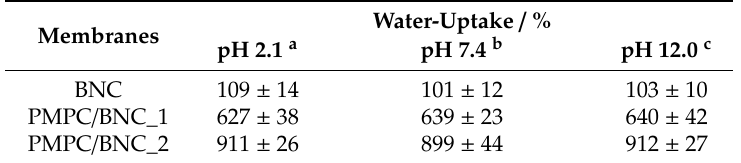
Table 2. Water-uptake (water-uptake) of neat BNC and the two PMPC / BNC nanocomposite membranes at di ff erent pH media for 48 h at